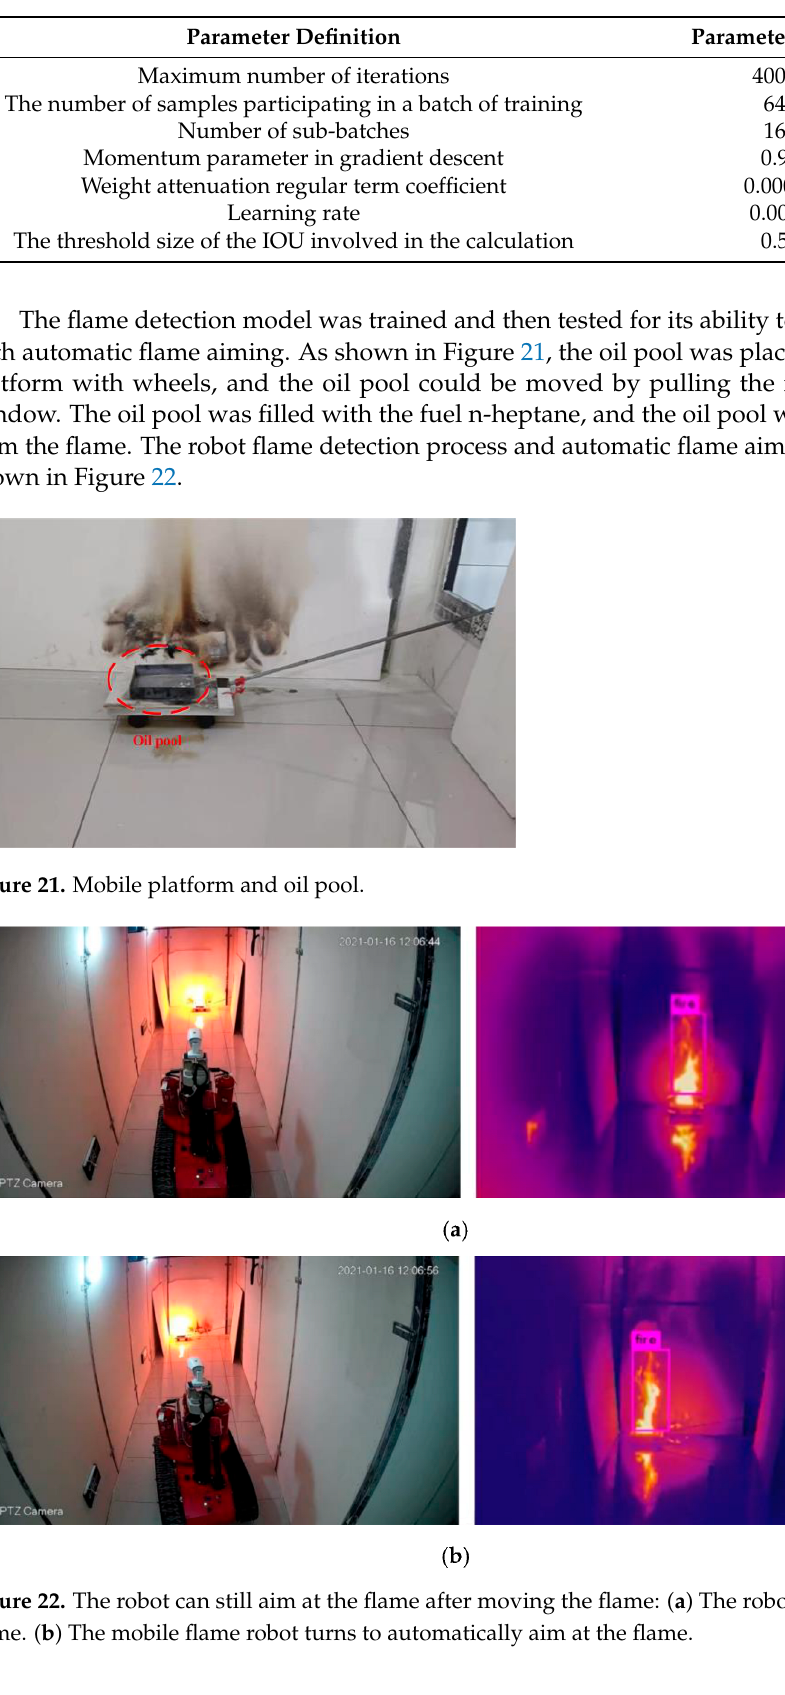
Table 4. Definition and setting of the experimental parameters.